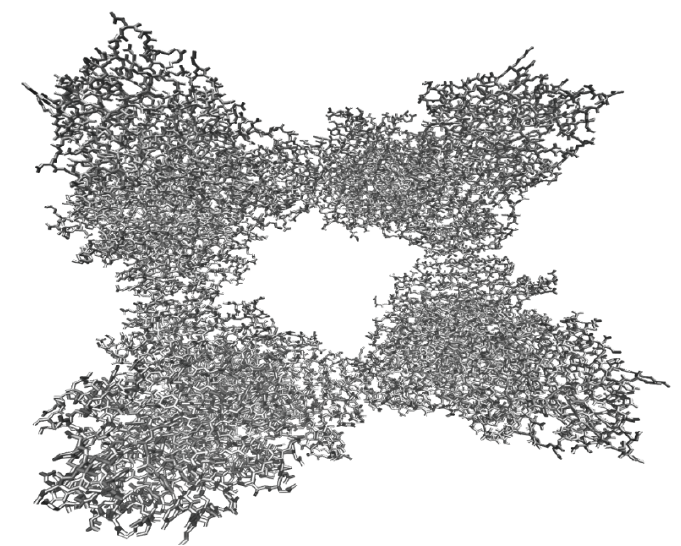
// www.rcsb.org / structure /